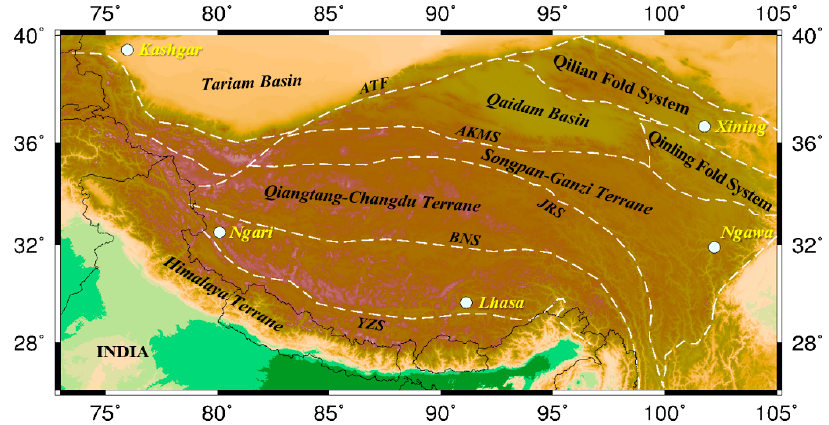
Figure 8. Tectonic map of the Tibetan Plateau. AKMS (Ayimaqin-Kunlun Mutztagh suture); ATF (Altyn Tagh fault); BNS (Bangong-Nujiang suture); JRS (Jinsha River suture); YZS (Yarlung-Zangbo suture).